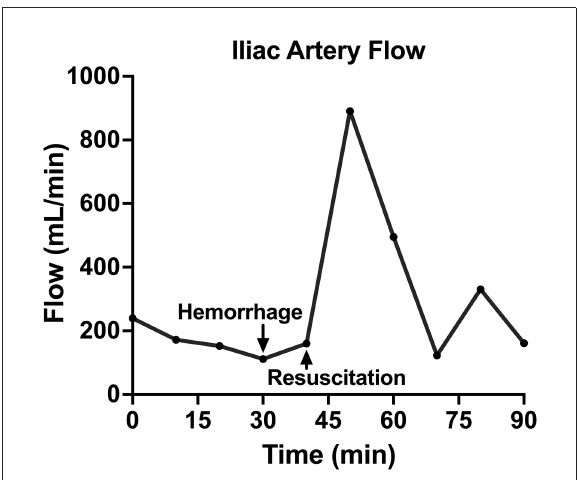
FIGURE5 The iliac artery blood flow of one animal over time, including baseline, hemorrhage, retransfusion of autologous blood, and a critical care